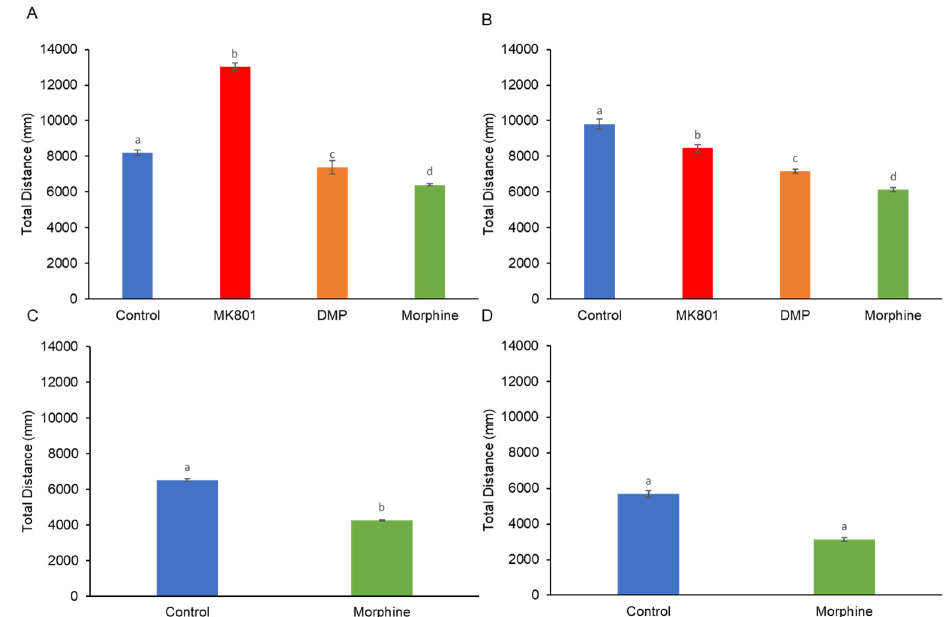
Figure 2. Effects of ( A ) short-term (F (3, 140) =46.84, p = 0.01) and ( B ) long-term (F (3, 140) = 124.51, p = 0.01) exposure to MK801, DMP, and morphine, and after withdrawal of ( C ) short-term (t (70) = 32.81, p = 0.04) and ( D ) long-term (t (70) = 184.32, p = 0.01) morphine treatment on the total distance travelled of zebrafish larvae (mm/5 min). Data expressed as mean ± SEM, n = 12 of 3 independent experiments. Different alphabets indicate statistically significant values, p < 0.05. Drug abbreviation: DMP, domperidone.